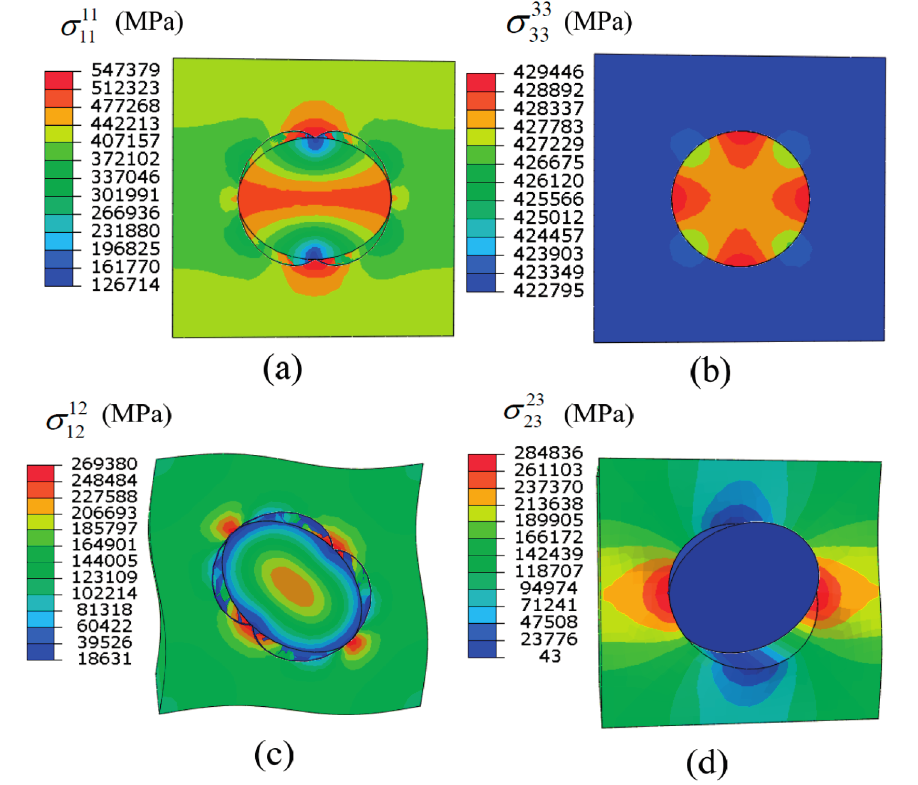
Figure 2. Stress influence functions obtained in the ( a ) tension along the y 1 ; ( b ) tension along the y 3 ; ( c ) shear along y 1 y 2 ; and ( d ) shear along y 2 y 3 linear perturbation steps in case  of 5 1 10 k − = ×